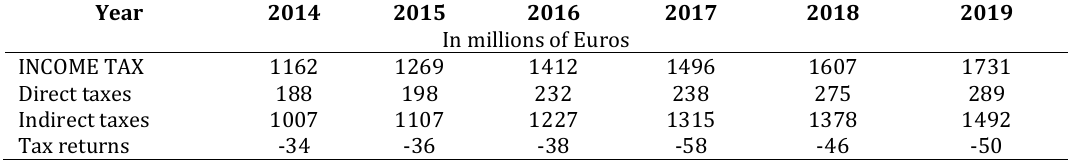
Table 2: Tax revenues in Kosovo in the period 2014-2019